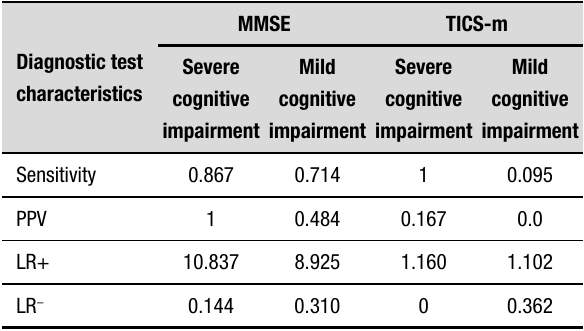
Table 4. Discriminant accuracy of Telephone Interview for Cognitive Status – modified and Mini-Mental State Examination questionnaire for mild and severe cognitive impairment from those without cognitive impairment using Diagnostic and Statistical Manual of Mental Disorders-V